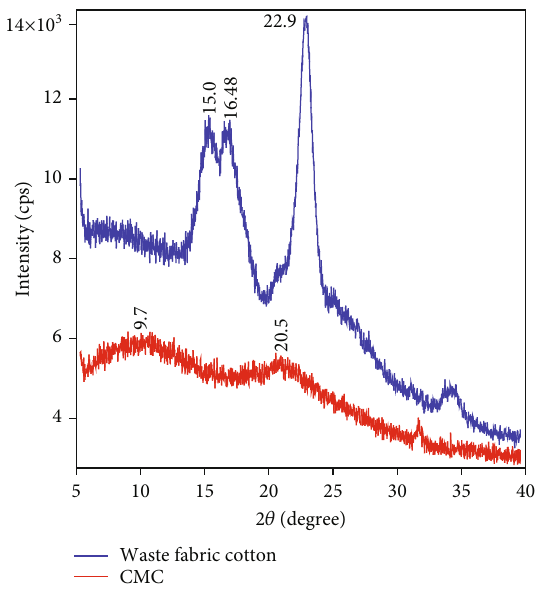
Figure 2: XRD pattern of waste textile cotton (blue) and CMC (DS — 0 : 998 ± 0 : 007 , red).